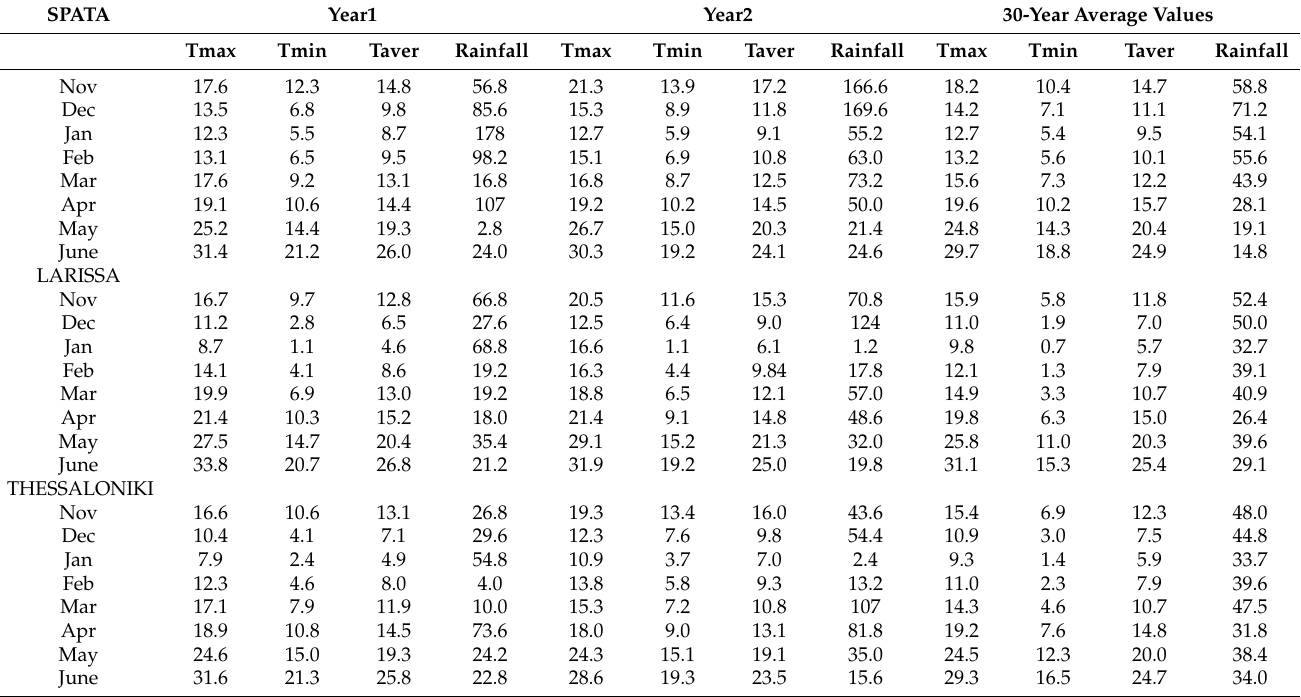
positive and blueness when negative. An average of three measurements for L*, a*, and b* values were recorded. Table 2. Monthly means of rainfall (mm), maximum (Tmax), minimum (Tmin), and average (Taver) temperatures ( ◦ C) for 2018–2019 (Year1) and 2019–2020 (Year2) growing seasons and the 30-year average at the three locations Spata, Larissa, and Thessaloniki where the experiments were